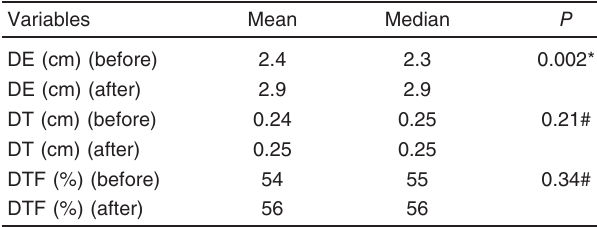
Table 1 Comparison of ultrasound diaphragmatic parameters before and after weaning